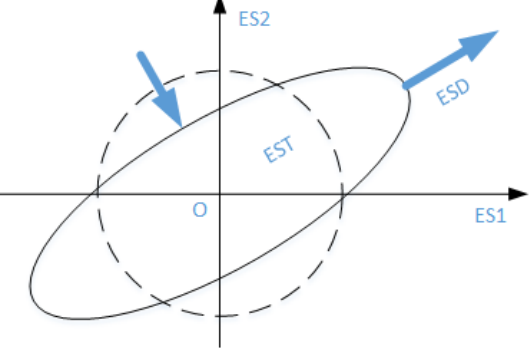
Figure 4. Schematic diagram of the ES response tensor (ESRT). Note: ES1 and ES2 are ES indicators, EST is the ES supply tensor, and ESD is the ES demand vector.